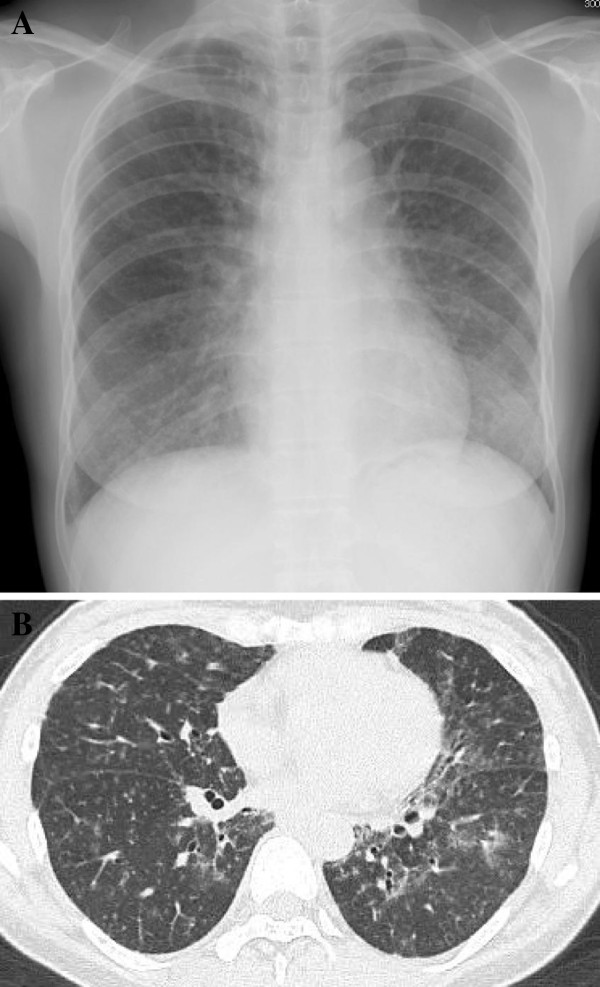
Radiological findings. A chest X-ray on admission, showing fine and diffuse nodular shadows in both lung fields (A). An initial CT scan of the chest demonstrated randomly-distributed micronodules and patchy ground-glass opacities (B).